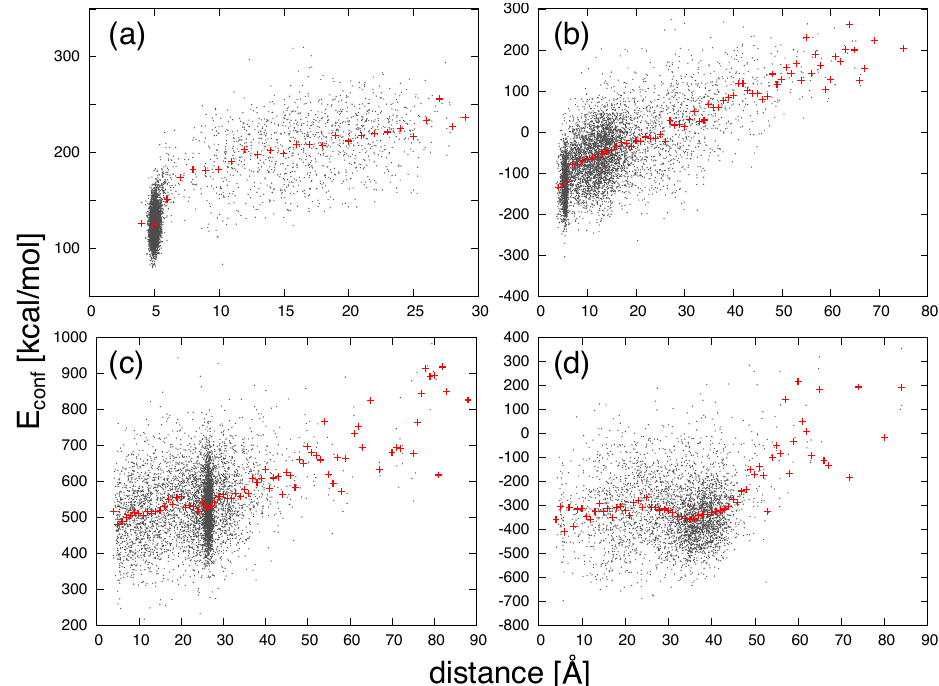
Figure 6. Conformational energy ( E conf ) of ( a ) CLN025, ( b ) mGTT, ( c ) mNuG2, and ( d ) m α 3D as a function of the end-to-end distance. A red point represents the average value for each width of 1